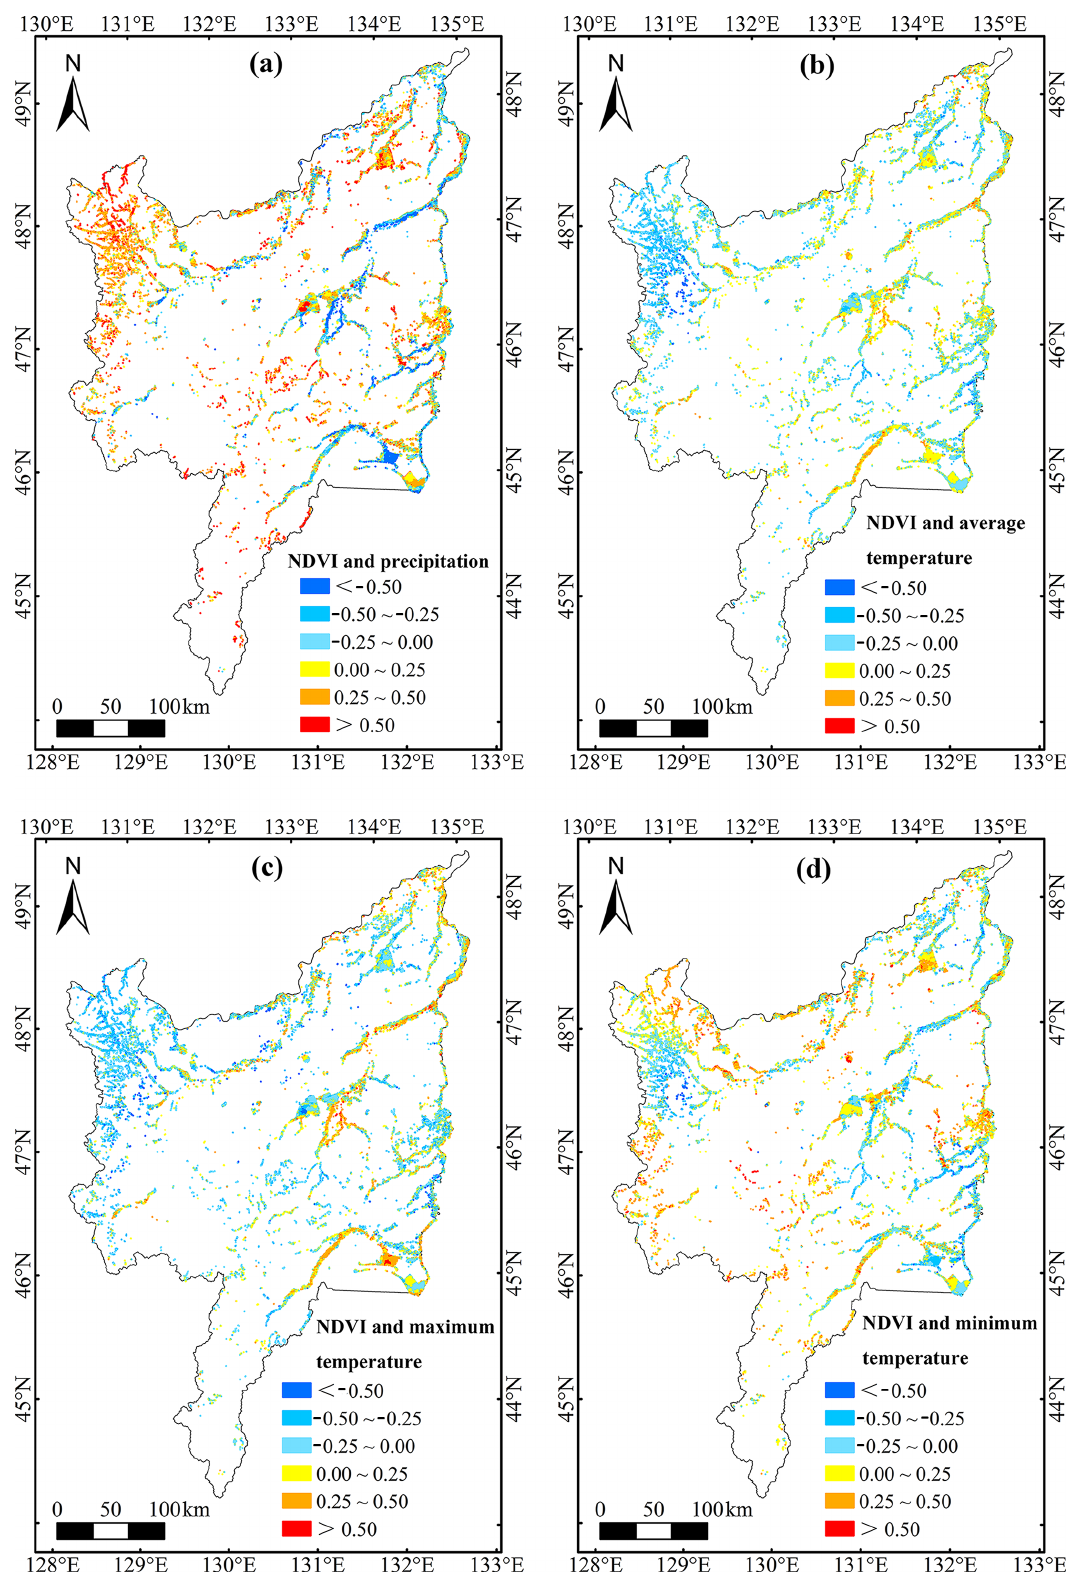
Figure 4. Spatial distribution of relationships between growing season NDVI of marsh vegetation and ( a ) precipitation, ( b ) average temperature, ( c ) maximum temperature and ( d ) minimum temperature during growing season in the study region from 2000 to